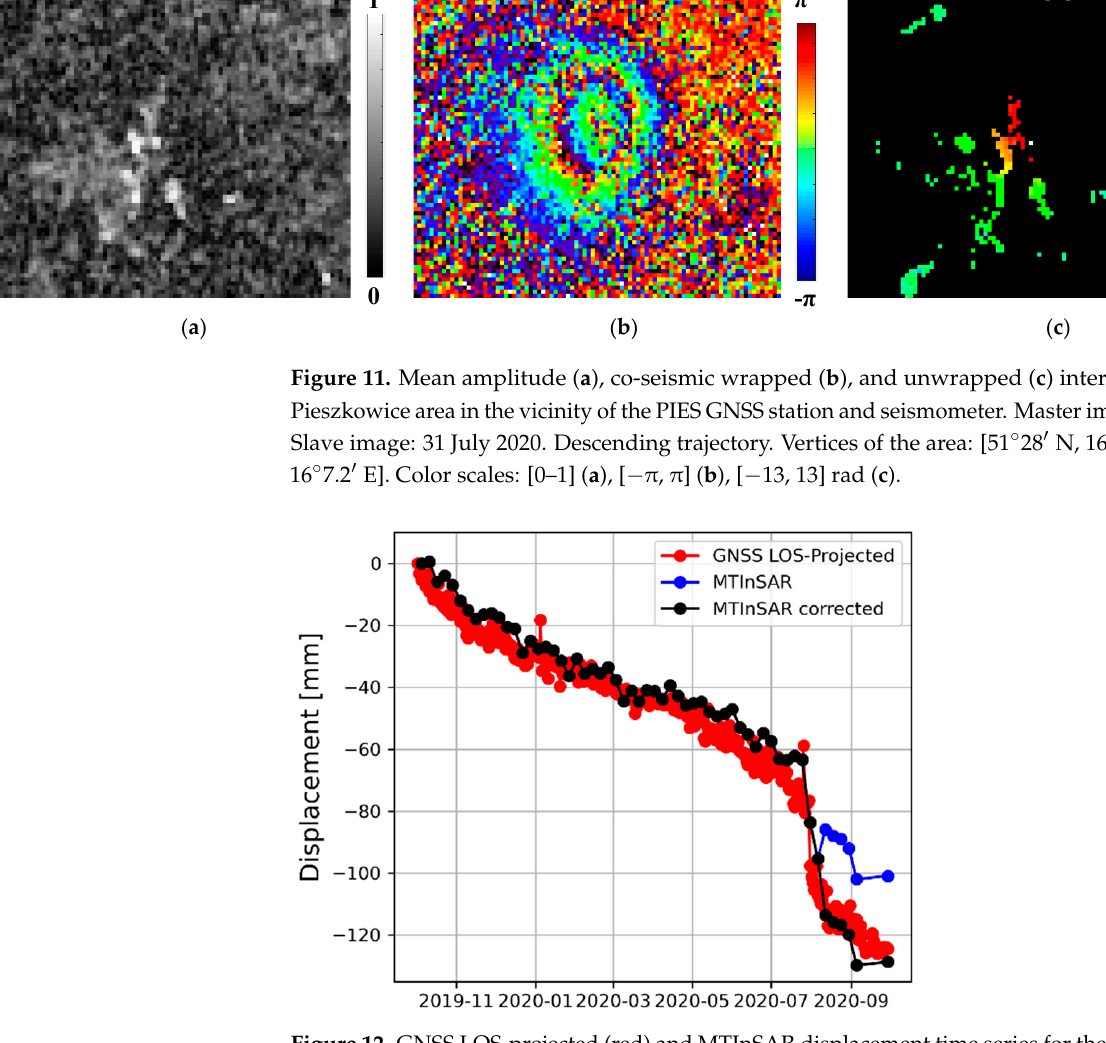
Figure 10. Mean amplitude ( a ), co-seismic wrapped ( b ) and unwrapped ( c ) interferograms of the Rudna mine area, in the vicinity of the WYZY GNSS station and seismometer. Master image: 19/07/2020. Slave image: 25/07/2020. Descending trajectory. Vertices of the area: [51°28.8’ N, 16°6’ E–